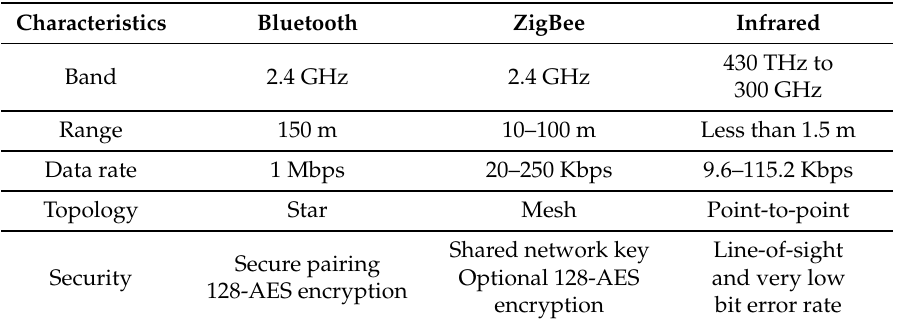
Figure 5. Common IoTHeF structure in a medical sensor network which includes smart healthcare gateways. Table 2. Comparison between different characteristics of Bluetooth, ZigBee and Infrared short-range communication